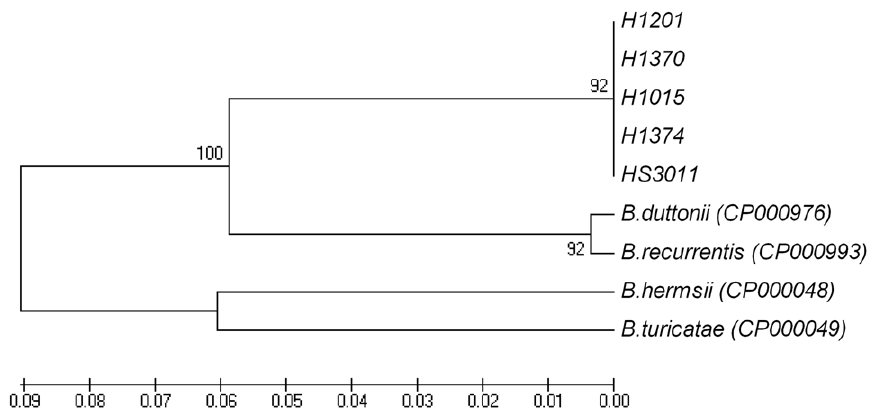
Figure 5. Phylogenetic tree based on pur A nucleotide sequences. The complete pur A sequences of B. persica isolates in Israel and the West Bank were compared to pur A sequences from other Borrelia species (accession number are given in parentheses). The Phylogenic tree was inferred using the UPGMA method. Parameters were as described in Figure 2. All positions containing gaps and missing data were eliminated from the dataset (Complete deletion option). There were a total of 1284 positions in the final dataset.